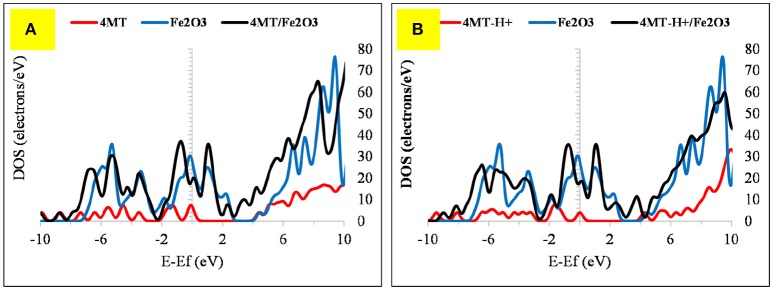
The DOS plot for: (A) 4MT, Fe2O3 and 4MT/ Fe2O3 and (B) (A) 4MT -H+, Fe2O3 and 4MT-H+/ Fe2O3 cluster system.